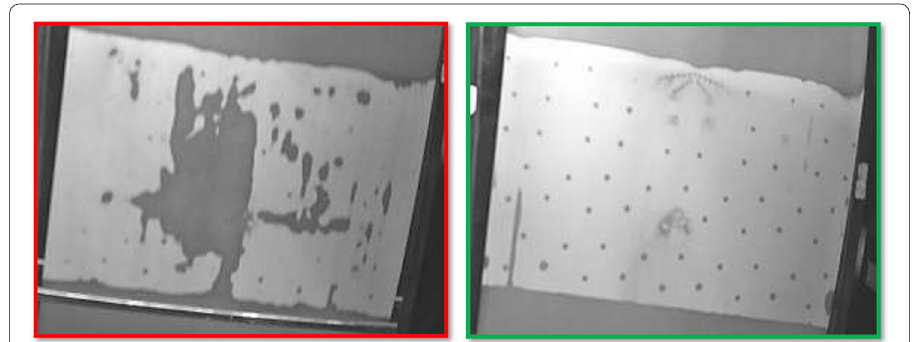
Fig. 3 Photographs of the plated strip taken from a “bad” (left) and a “good” anode condition (right). The right picture shows signs of wear. The photographs are evaluated manually by a team of experts